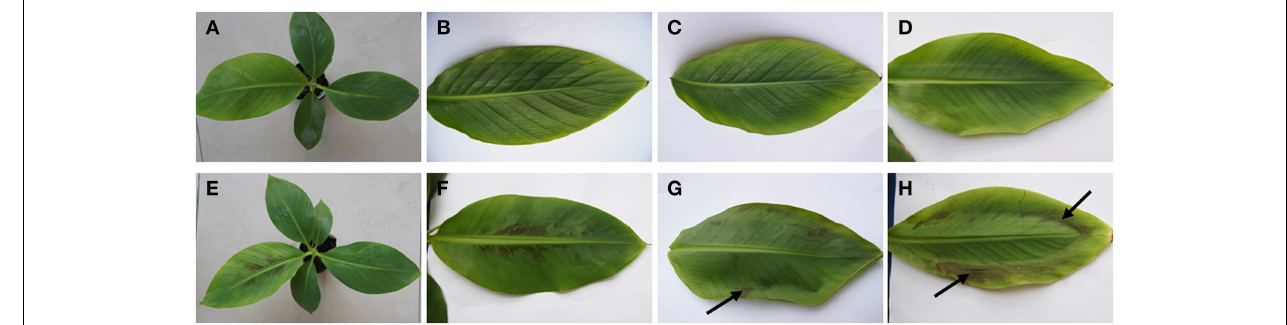
turgor. (E,F) The control plant and the youngest fully-developed leaf of Musa spp. AAA cv. Baxijiao (chilling-sensitive genotype). (G) The youngest fully-developed leaf of the sensitive genotype incubated at 10 ◦ C for 3 days, showing hydrophanous spots appearing on the leaf (arrows). (H) The youngest fully-developed leaf of the sensitive genotype incubated at 7 ◦ C for 3 days, showing more severe chilling injury symptom.